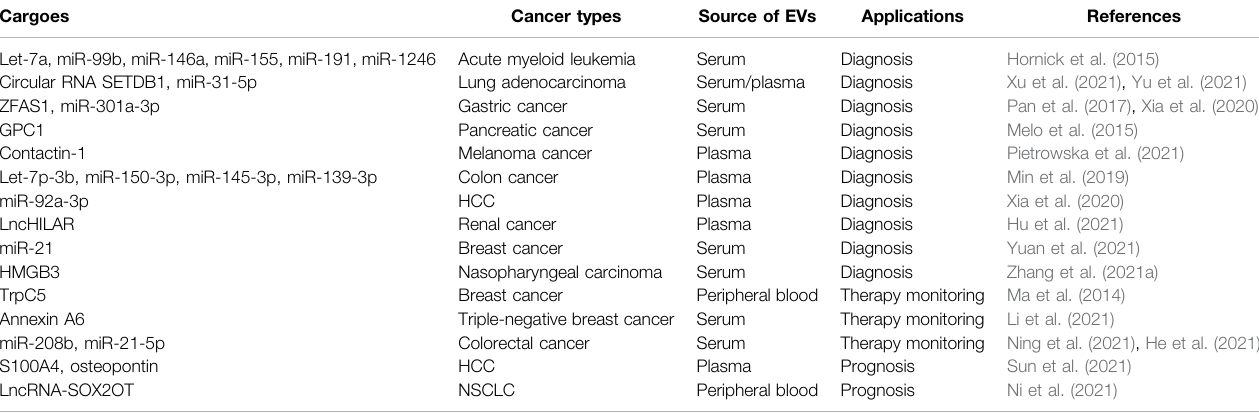
TABLE 3 | Tumor-derived EVs as biomarkers in cancer diagnosis and treatment.